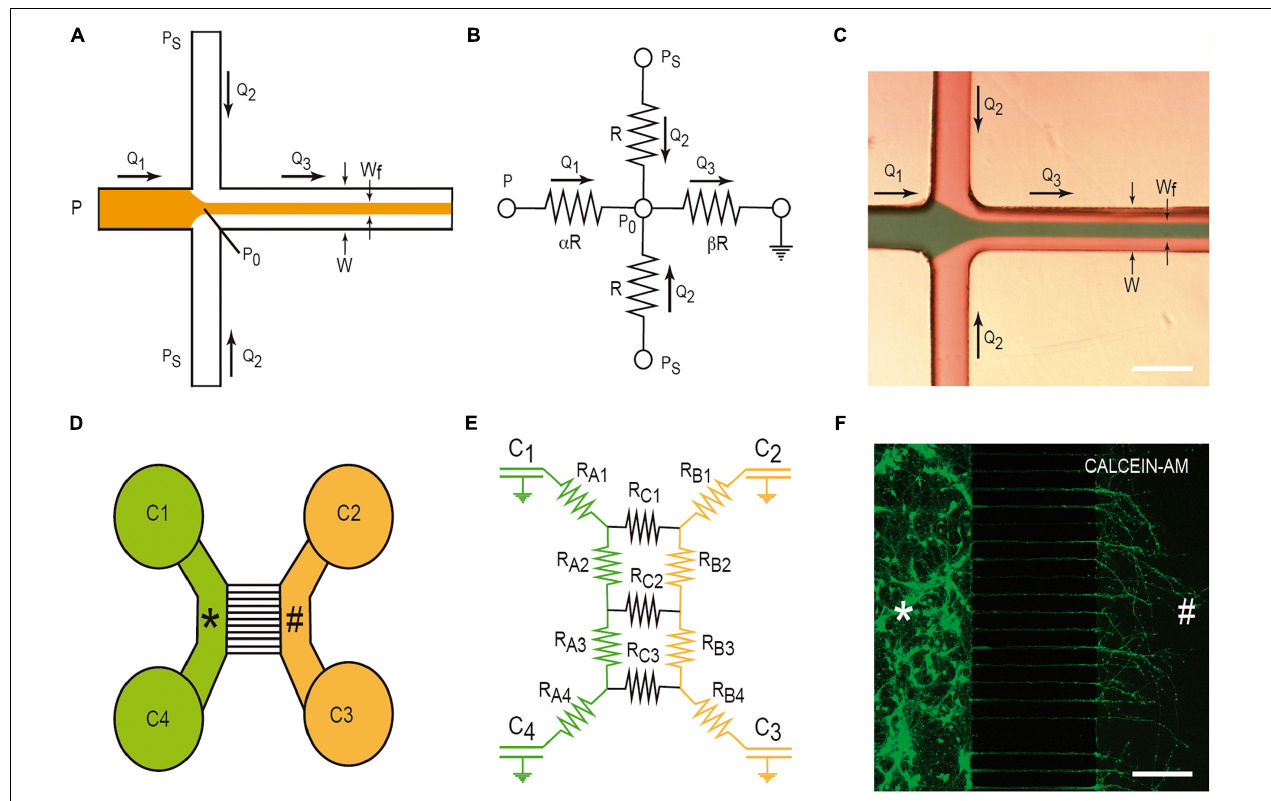
FIGURE 3 | Examples of LOC devices and microfluidic platforms. Microfluidic hydrofluidic mixing device (A–C) and compartmentalized LOC device (D–F) . For each device, the correlative fluidic and electric model is included. In (C,F) , we provide two examples of the generation of hydrodynamic focusing (C) and the growth of axons labeled with CalceinTM. The two different compartments are labeled with * and # in (D–F) . Please see manuscript section “Some Basic Physical Concepts in Microfluidics” for details of the correlation between fluidics laws and electric laws in LOC